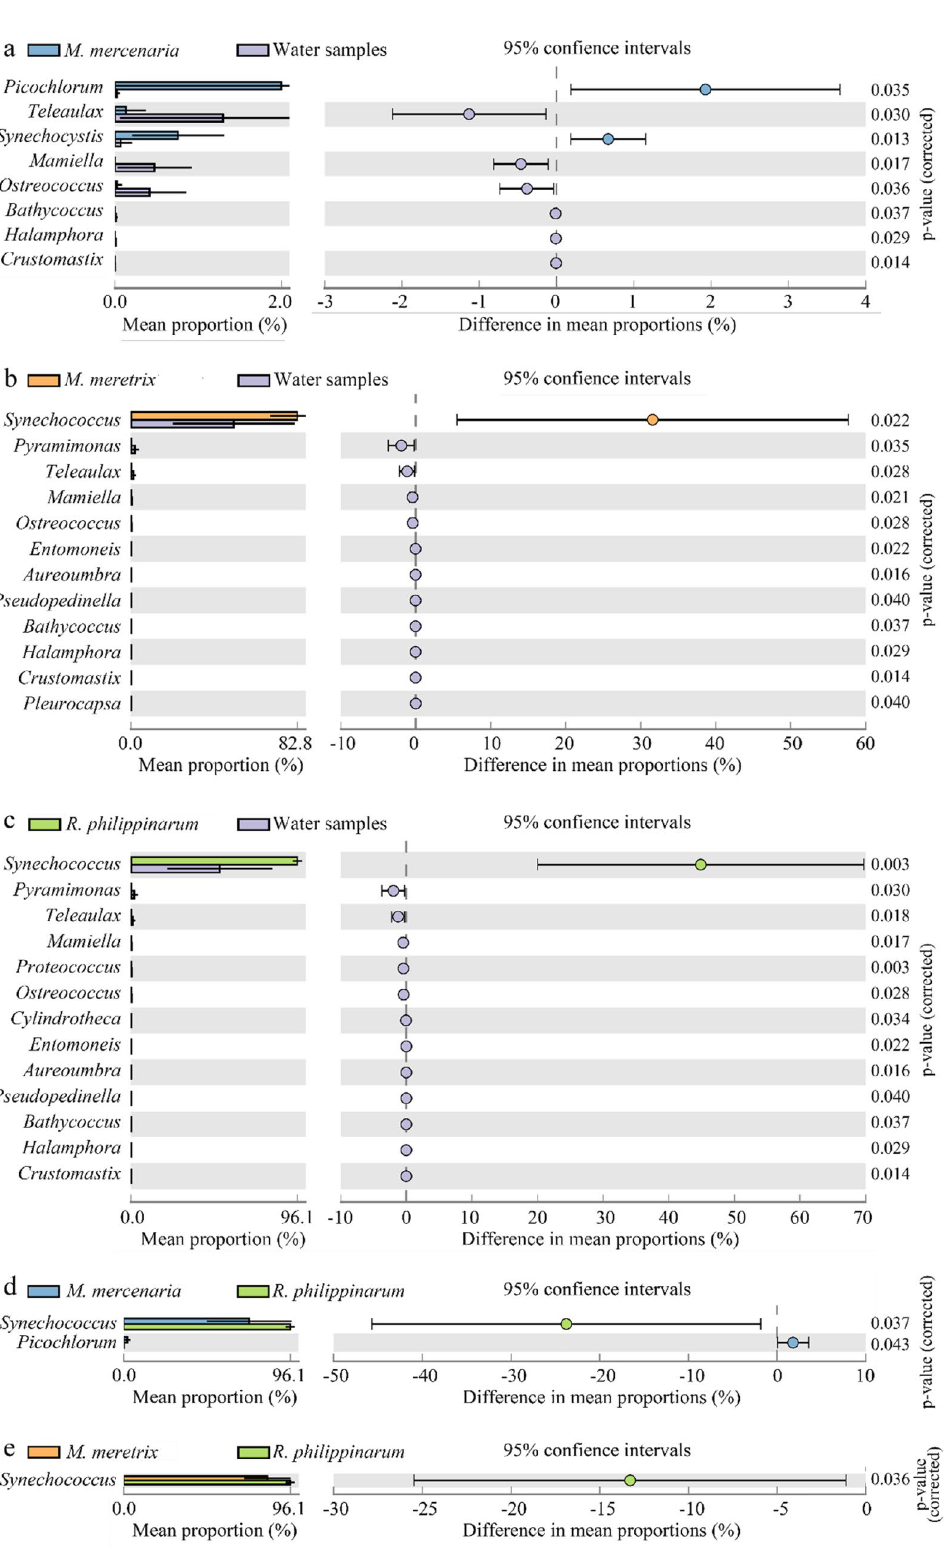
Figure 6. Extended error bar plots showing phytoplankton at the genus level that differed significantly between the M. mercenaria hepatopancreas and water samples ( a ), M. meretrix hepatopancreas and water samples ( b ), R. philippinarum hepatopancreas and water ( c ), between the hepatopancreas samples of M. mercenaria and R. philippinarum ( d ), and between the hepatopancreas samples of M. meretrix and R. philippinarum ( e